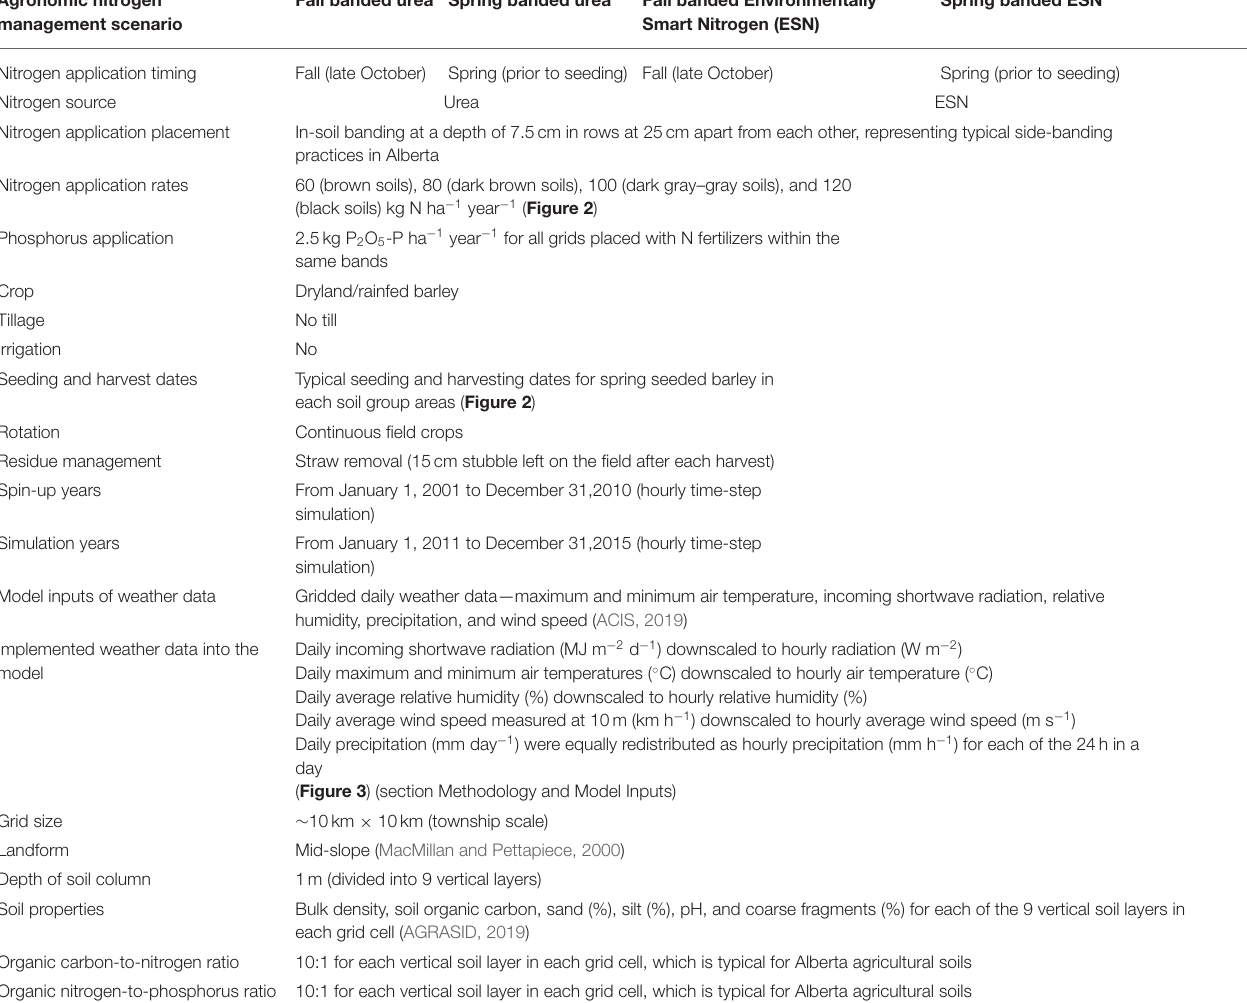
TABLE 1 | Key model inputs to ecosys model to simulate effects of agronomic nitrogen management on crop nitrogen uptake and nitrogen losses from simulated barley fields across the agricultural areas of Alberta during 2011–2015. Agronomic nitrogen management